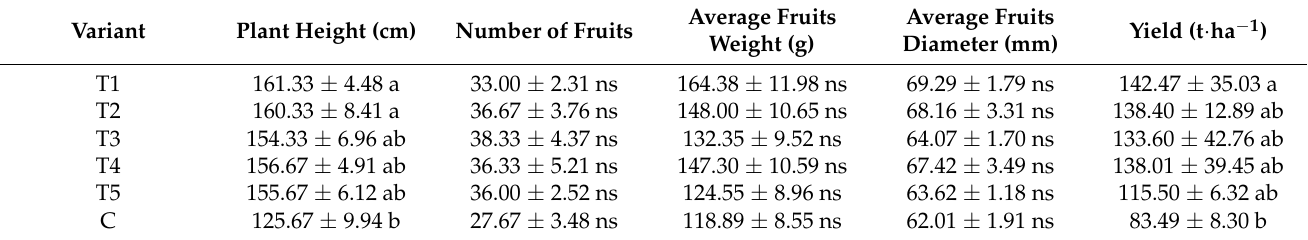
Table 3. The biometric measurements of tomato plants and fruits under the influence of different electric currents